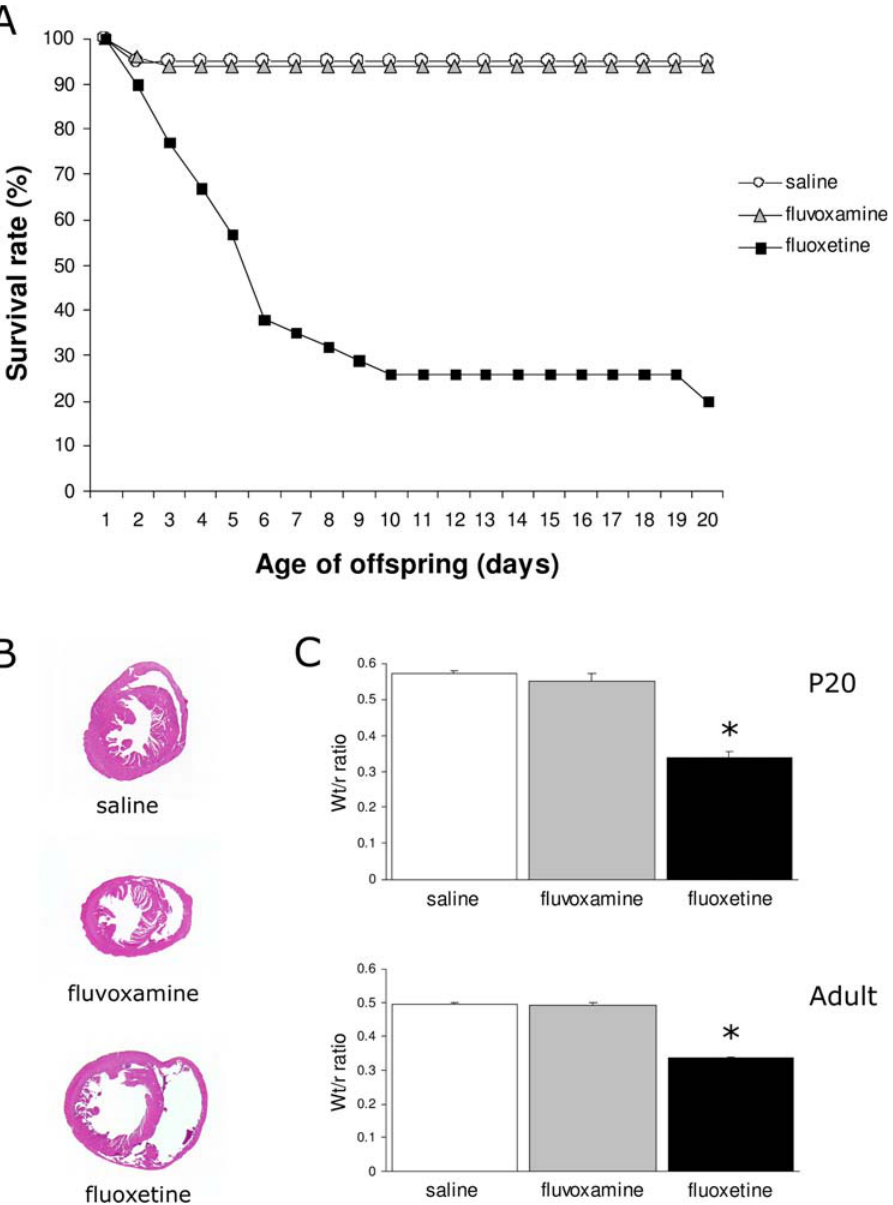
Figure 2. (A) Survival rates of mice prenatally treated with saline (white circle), fluvoxamine (gray triangle) or fluoxetine (black square) from 1 to 20 days after birth. 81% of the fluoxetine-treated offspring died within 20 days after birth. (B) HE-staining of a horizontal section of the hearts showed dilated cardiomyopathy in fluoxetine-treated offspring. (C) Wt/r ratios of the left ventricle presented as mean 6 S.E.M for groups treated with saline (white bars), fluvoxamine (gray bars) and fluoxetine (black bars) at P20 (N=6 for saline and fluvoxamine, N=4 for fluoxetine) and adulthood (N=5 for saline and fluvoxamine, N=3 for fluoxetine). Wt/r=wall thickness/radius, * p , 0.01.